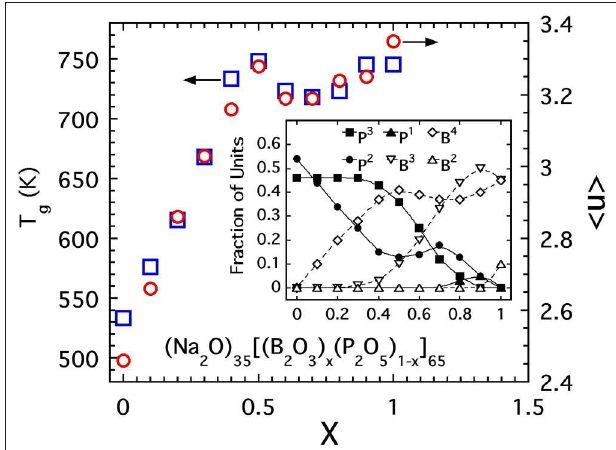
FIGURE 12 | The glass transition temperature of alkali germanates (Shelby, 1974 ; open circles) and alkali borates (Gupta and Mauro, 2009; open squares) as a function of the mole fraction of alkali oxide with scale on the left side. Also plotted are the coarse-grained connectivity (discussed in the text) for alkali germanates (solid circles) and alkali borates (solid squares) with scale on the right side. Inset shows the close correspondence between the rapid decrease in 1,300 ◦ C viscosity of alkali germanate melts ( Riebling, 1963; solid symbols) and the rapid decrease in coarse-grained connectivity (open diamonds).